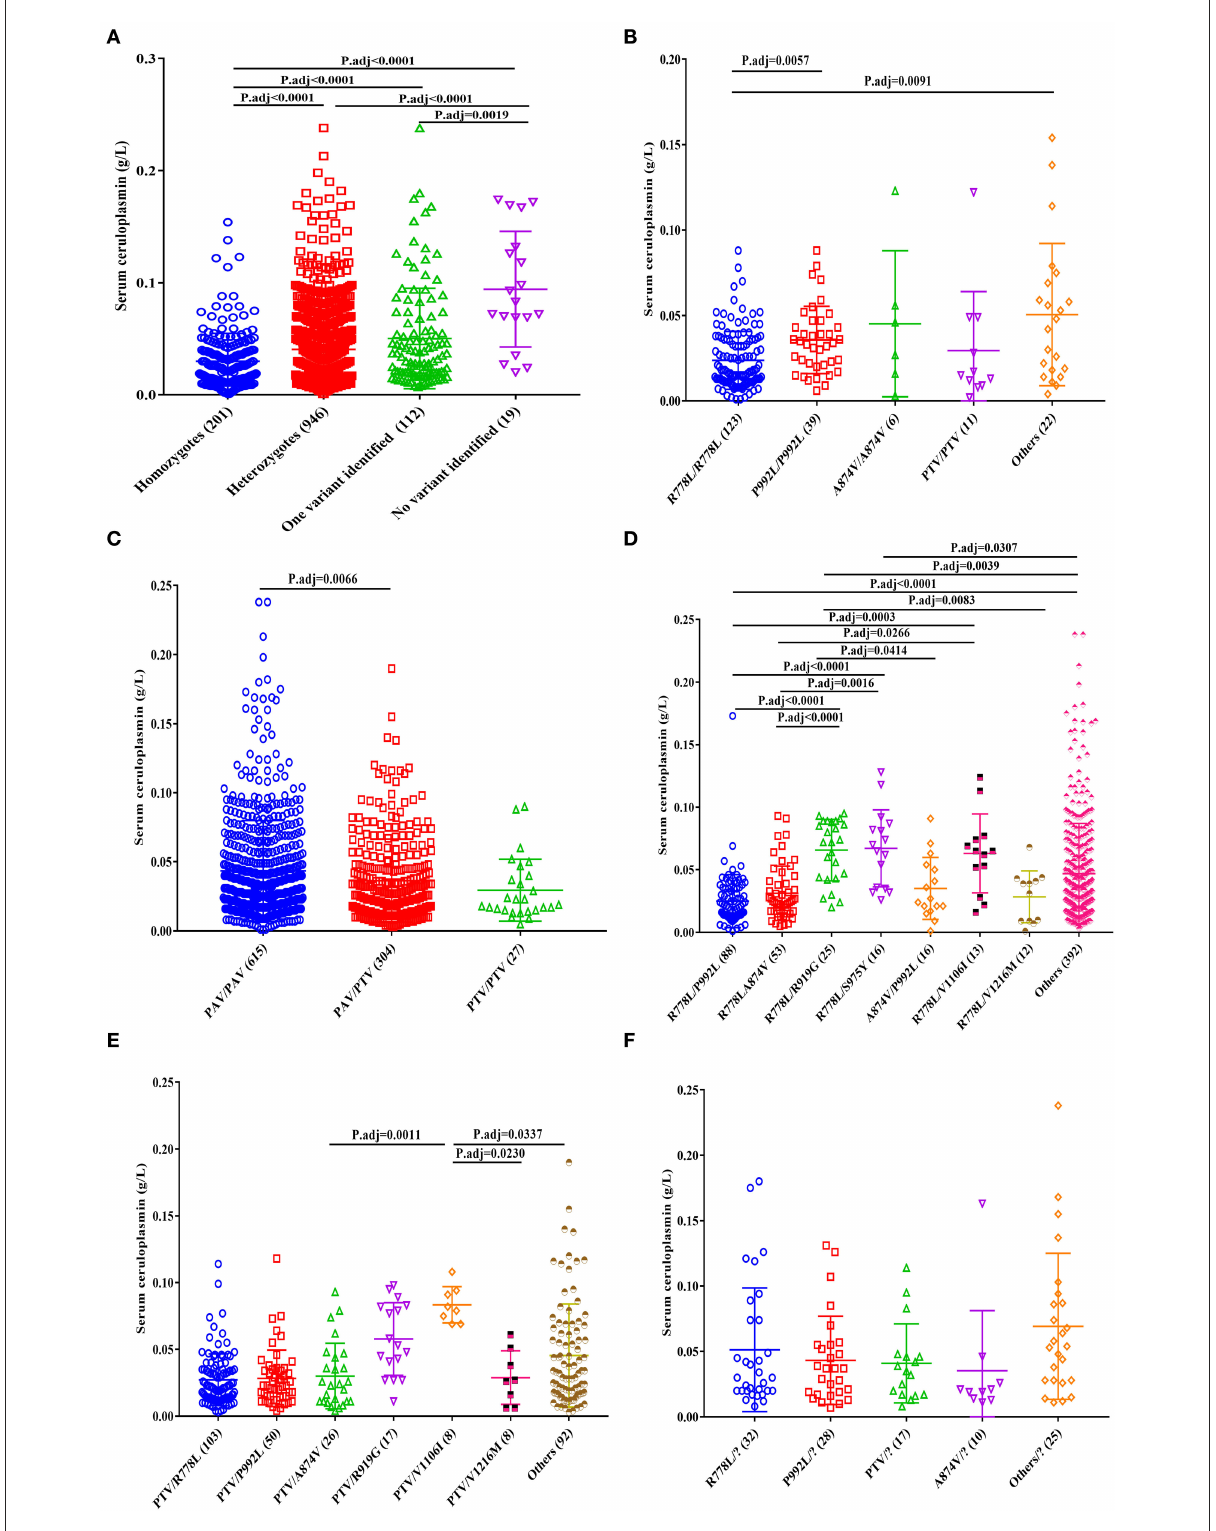
FIGURE3 Effect of common ATP7B genotypes on serum ceruloplasmin levels of patients with WD. (A) Total, (B) homozygotes, (C) heterozygotes, (D) PAV/PAV, (E) PTV/PAV, and (F) one variant